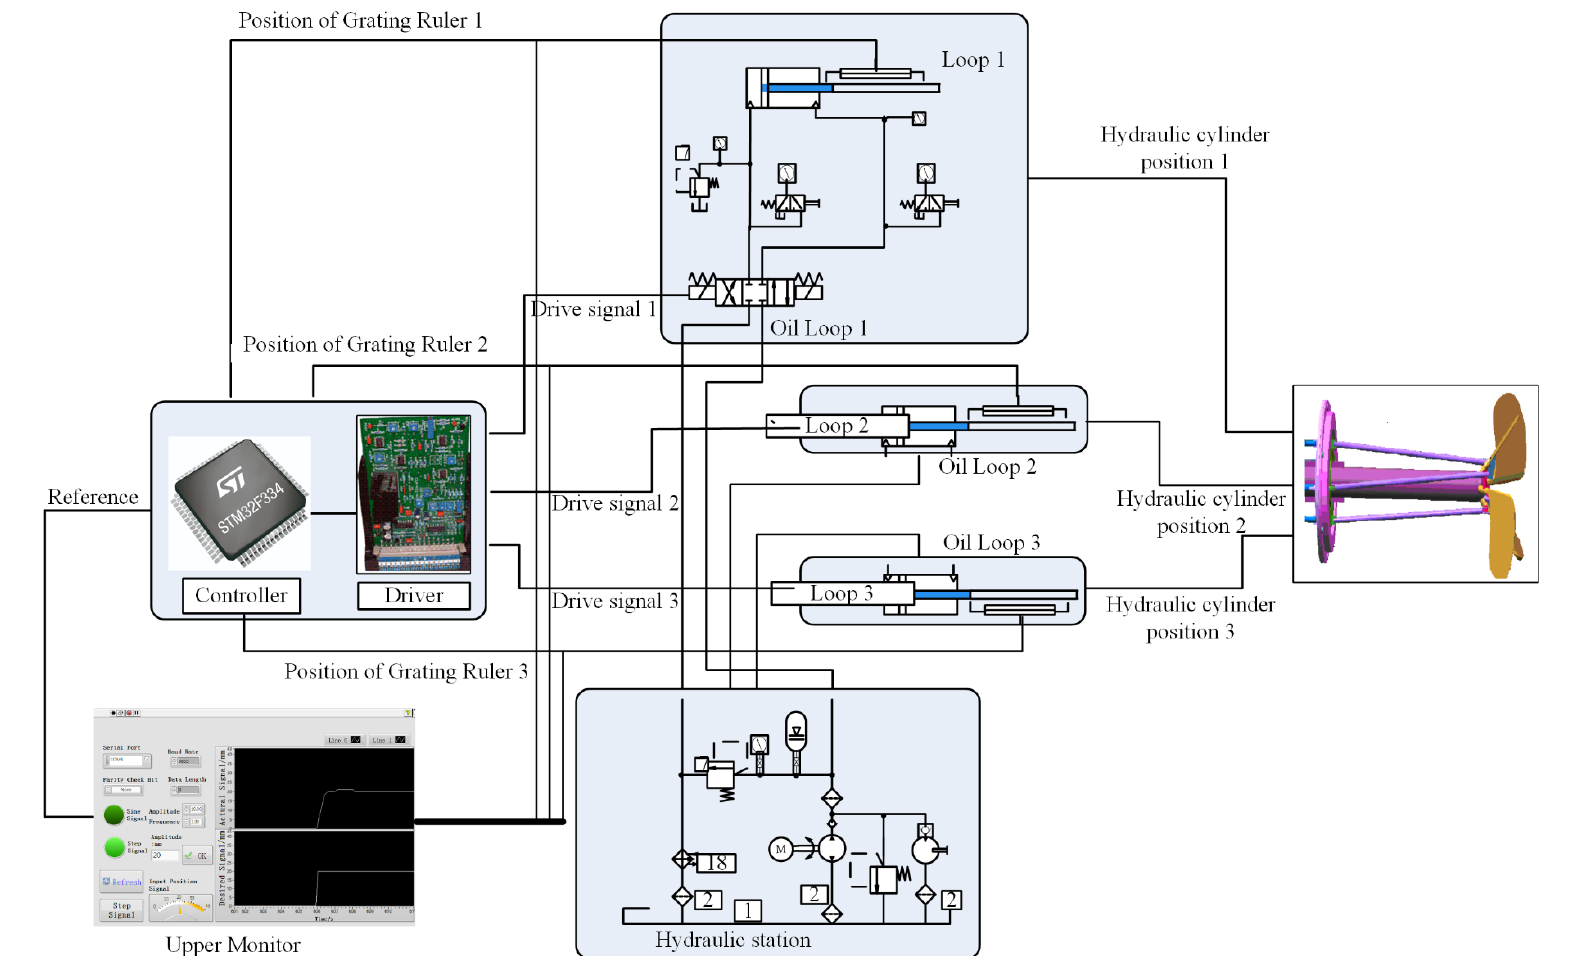
Figure 10. Scheme of the scale model of the CPP system.